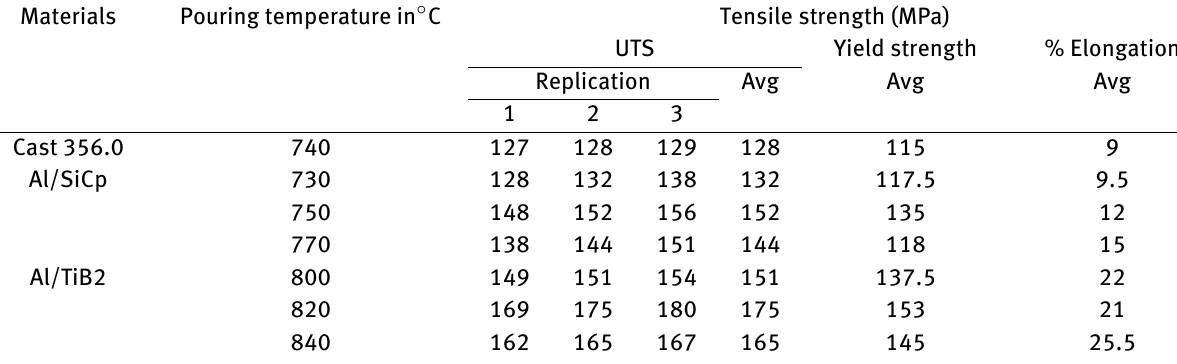
Table 2: Tensile strength of Al/SiCp and Al/TiB 2 MMCs Materials